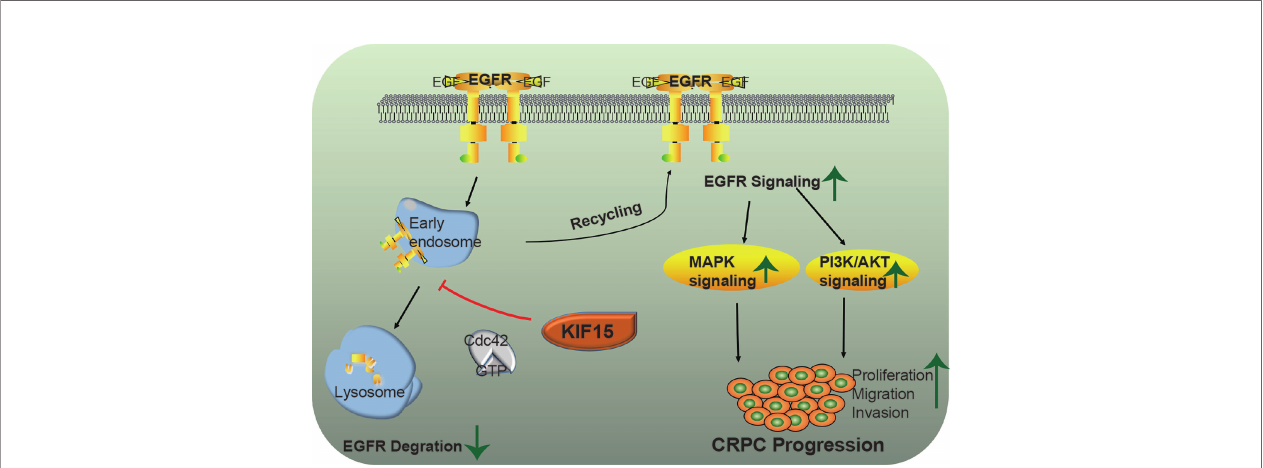
FIGURE 6 | A putative model illustrating the role of KIF15 in up-regulation of EGFR signaling to promote CRPC. EGFR is ubiquitinated by EGF stimulation and sorted to the endosome, resulting in its degradation in lysosomes. KIF15 blocks EGFR from undergoing lysosomal degradation by activating Cdc42 and increases EGFR recycling back to the cell membrane. The MAPK/ERK and PI3K/AKT signaling pathways are activated, both of which can promote the proliferation and invasion of CRPC